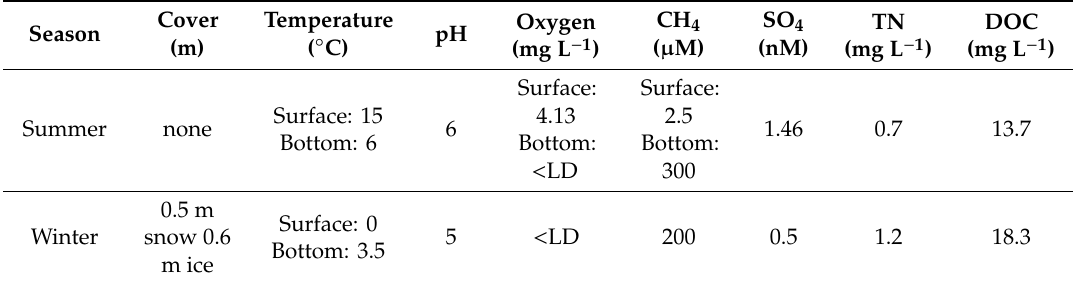
Table 1. Water chemistry of SAS2A. LD: limit of detection, TN: total nitrogen, DOC: dissolved organic carbon. Surface and bottom measurements are provided when the water column was